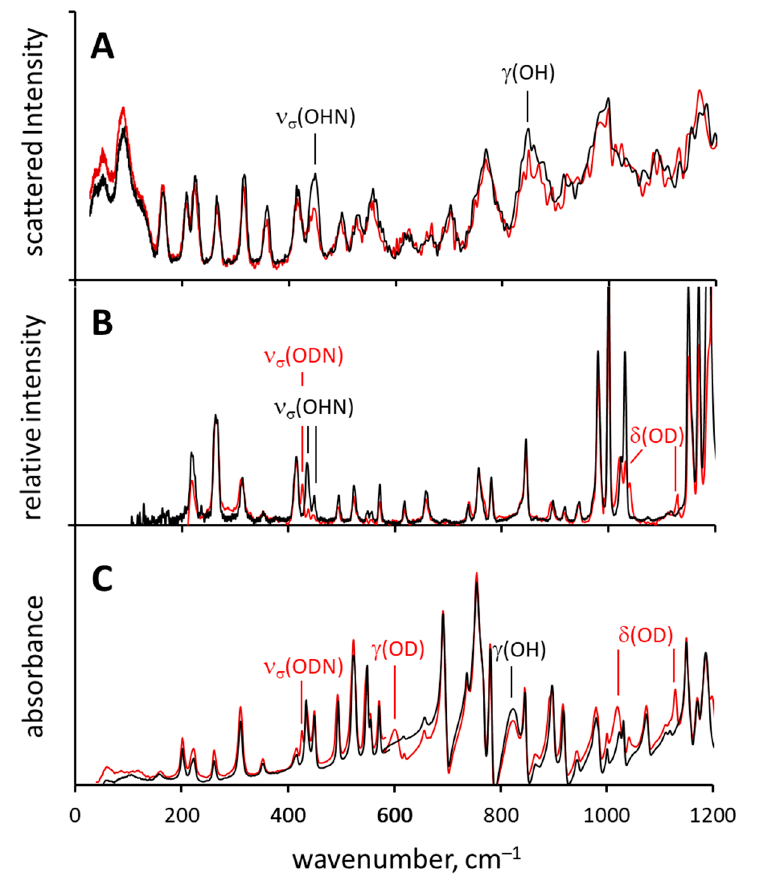
Figure 3. Normalized experimental IINS ( A ), Raman ( B ) and IR ( C ) spectra of SA (black line) and its deuterated derivative SA-OD (red lines).